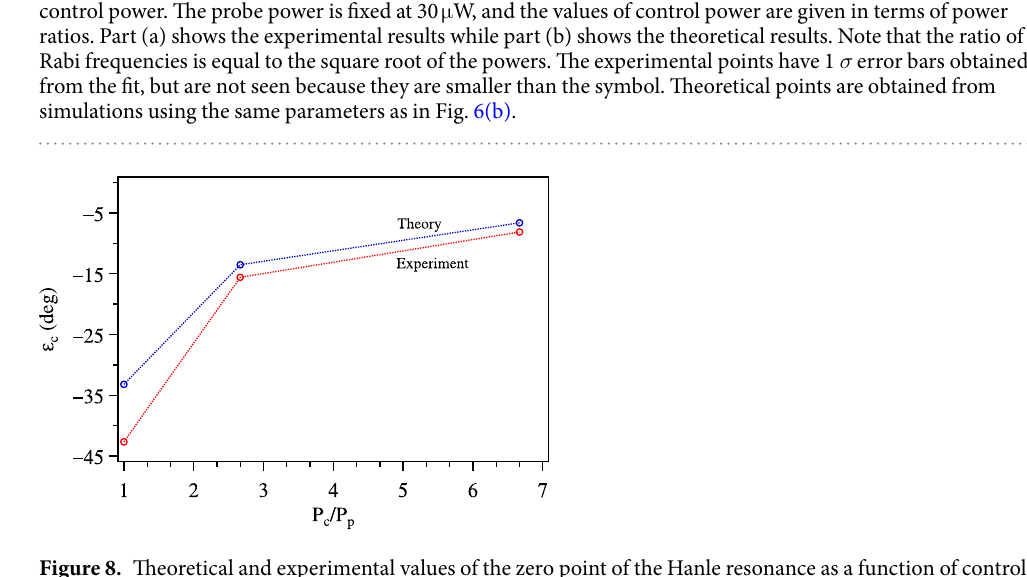
Figure 8. Theoretical and experimental values of the zero point of the Hanle resonance as a function of control power. For ease of comparison to other data, the control power is given as a